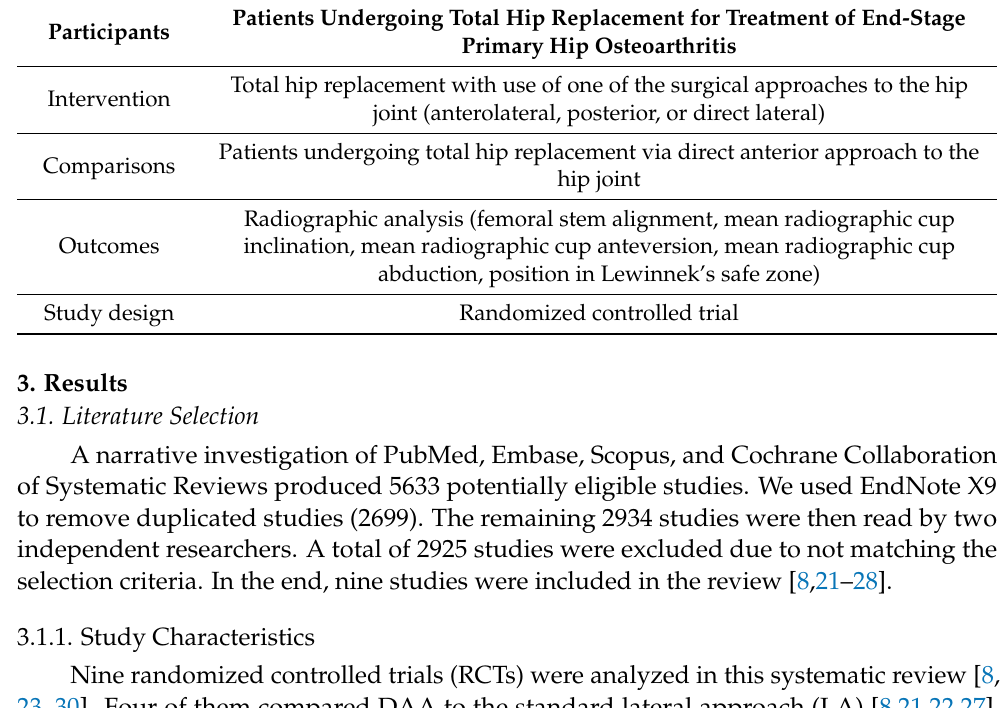
Table 1. PICOS strategy for study characteristics.